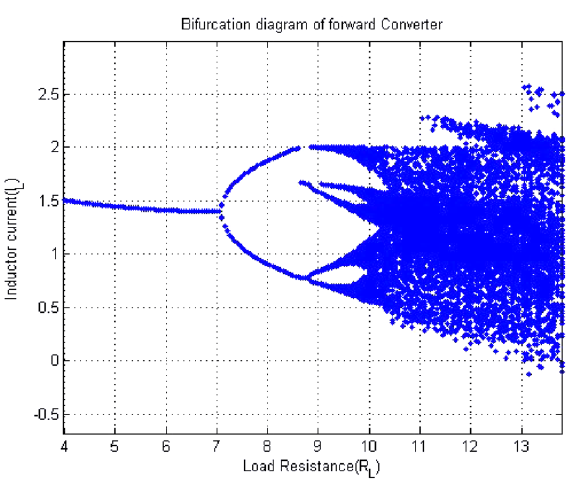
Figure 5. Bifurcation diagram of forward converter when R L changing from R L = 4 (cid:31) to R L = 12 (cid:31) .